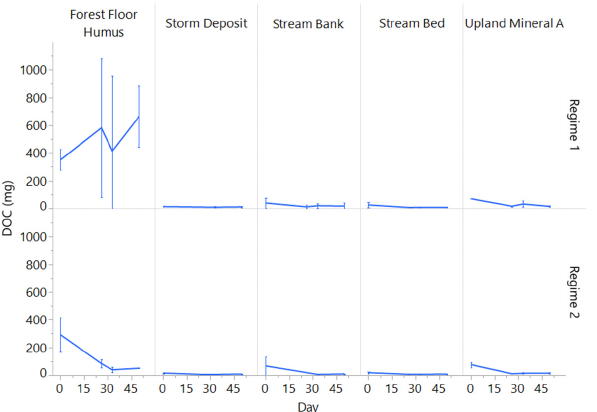
Figure 7. Temporal patterns of porewater DOC over the incubation period for the five sources and two moisture regimes. Regime 1: continuously moist, and regime 2: dry ‐ wet cycle.